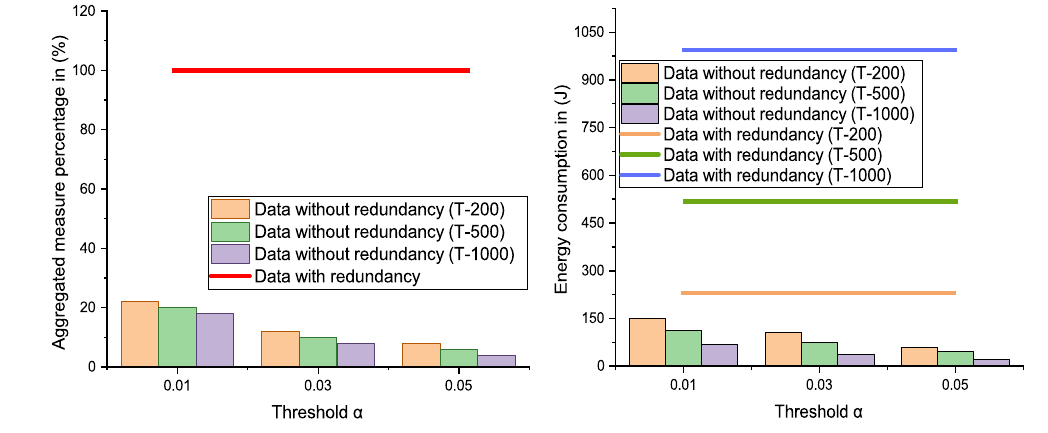
Figure 3. The effect of data similarity on the performance of our